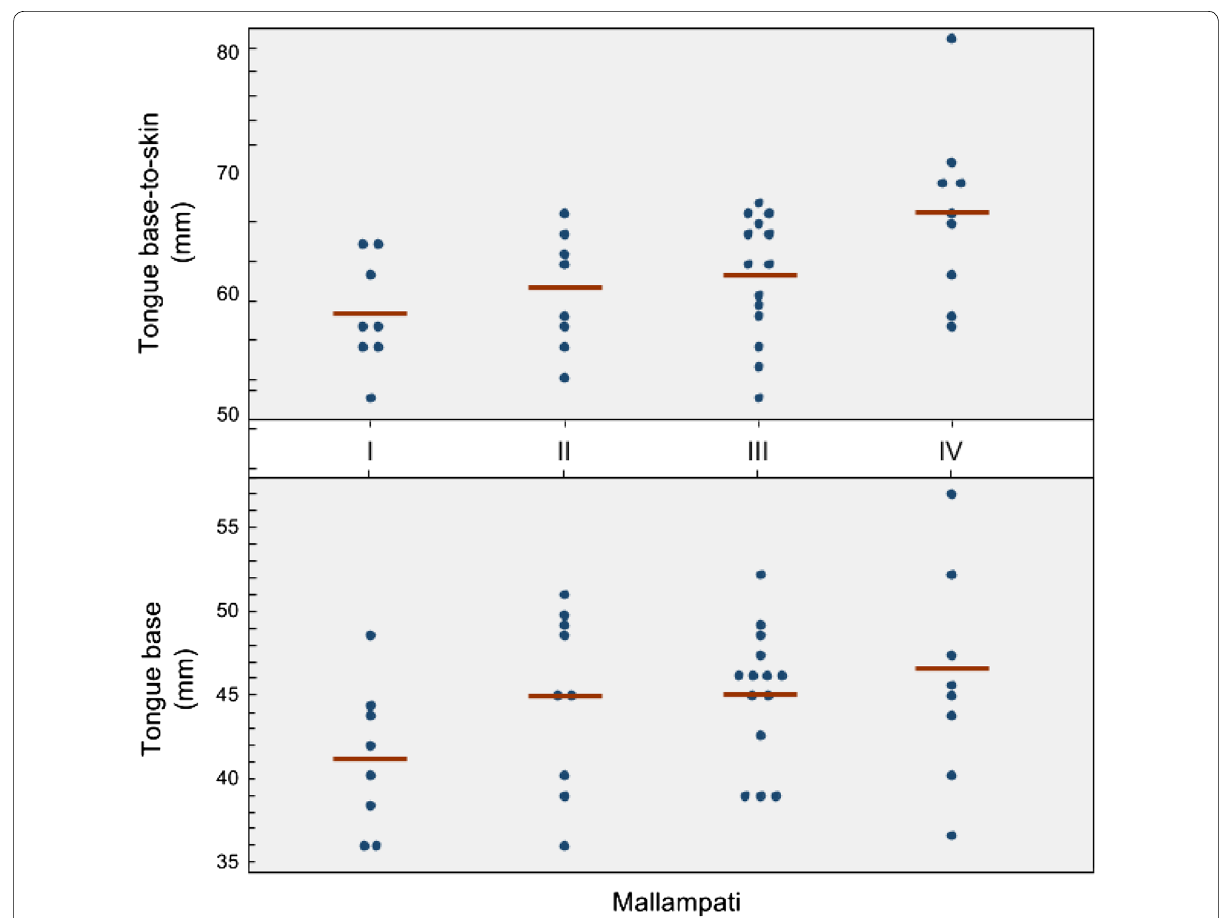
Fig. 4 Tongue US measurements demonstrate linear increase as compared to